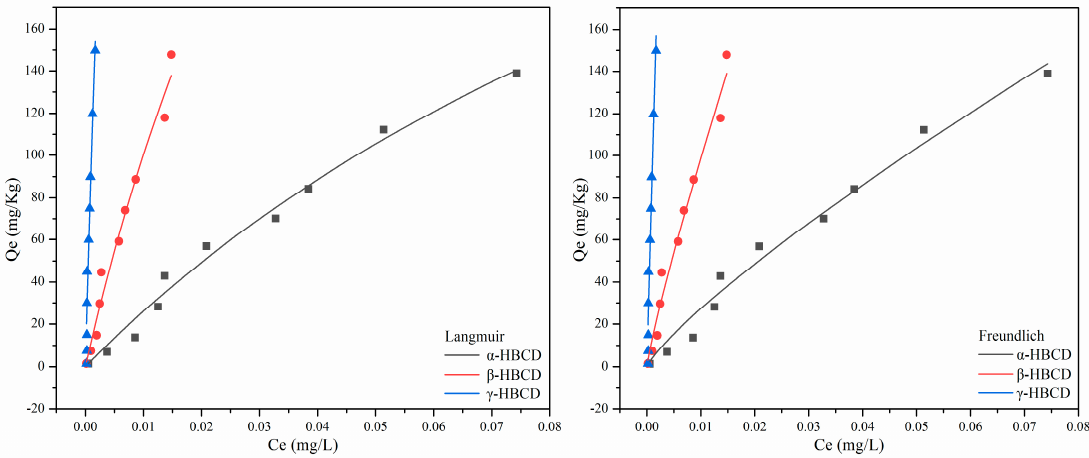
Figure 3. Sorption isotherms of HBCDs in the sediment.